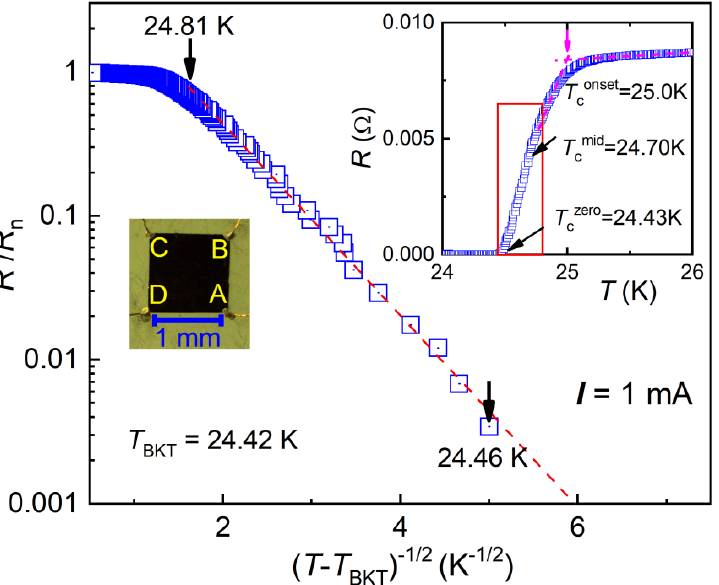
Figure 1. Temperature dependence of normalized resistance R/R n in the superconducting transition of Ba(Fe 0.914 Co 0.086 ) 2 As 2 crystal (photographed on the left inset). Rn is the normal-state resistance, obtained by a linear extrapolation from 50 K to 35 K. The inserted plot shows the superconducting transition in normal linear scale. The related characteristic temperatures are indicated with